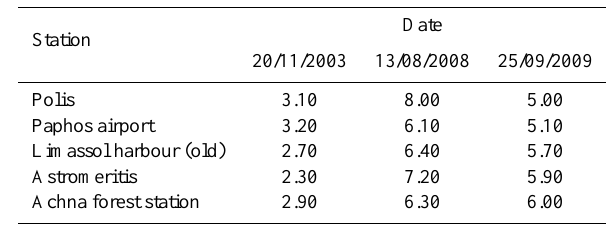
Table 3. Same as Table 2, but for Mandria irrigated area.